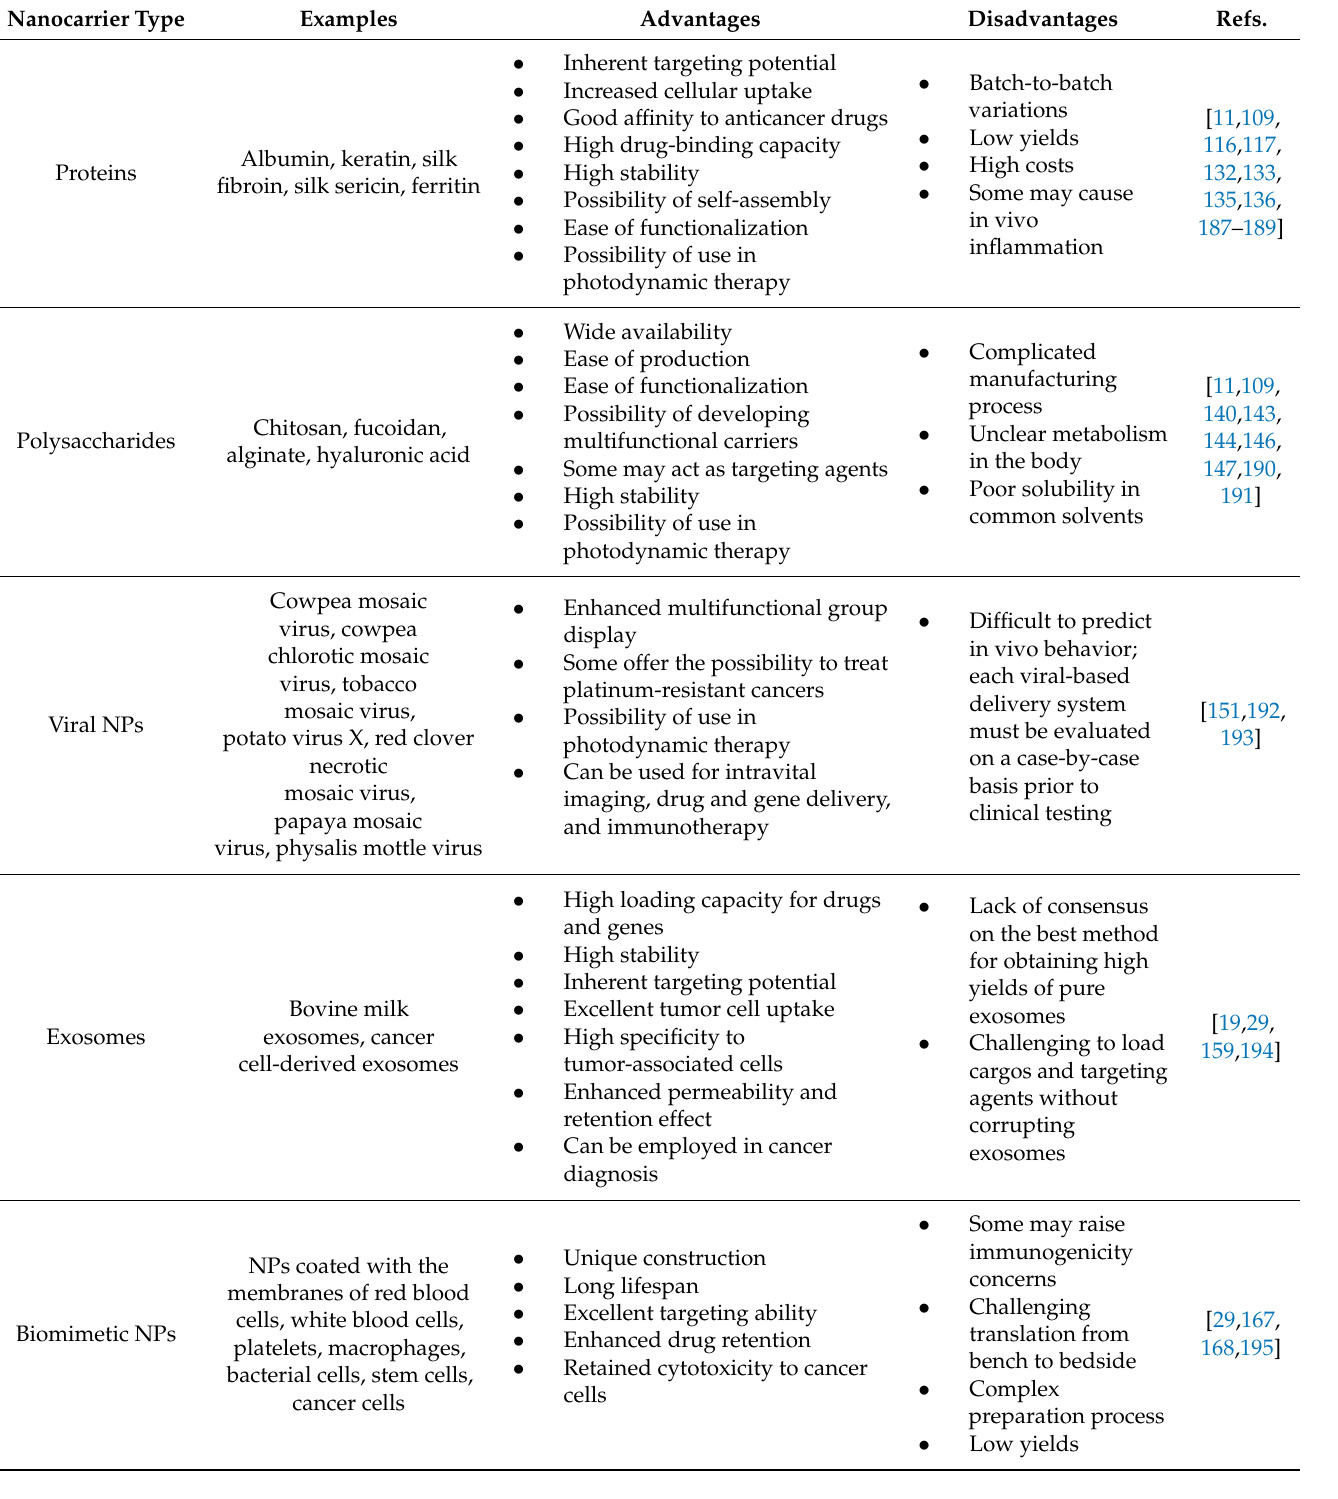
Table 3. Advantages and disadvantages of main discussed natural nanocarriers for cancer